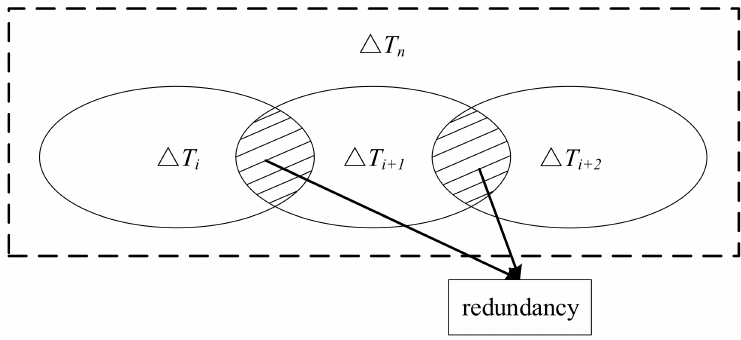
Figure 6. Expression of incremental information, when the interval equals three edge collapses. ∆ T n represents the incremental information, after merging. ∆ T i represents the incremental information between the S i and S i + 1 scales. ∆ T i + 1 represents the information between the S i + 1 and S i + 2 scales. Moreover, ∆ T i + 2 represents the incremental information between the S i + 2 and S i + 3 scales. Therefore, ∆ T n can represent the incremental information between the S i and S i + 3 scales. This simple merging will generate an information